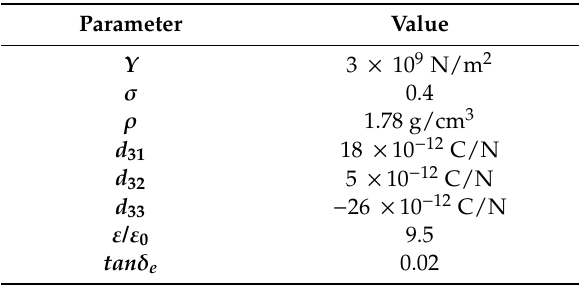
Table 2. Constants used to define β -phase PVDF flexible film bulk acoustic resonator (FBAR) in